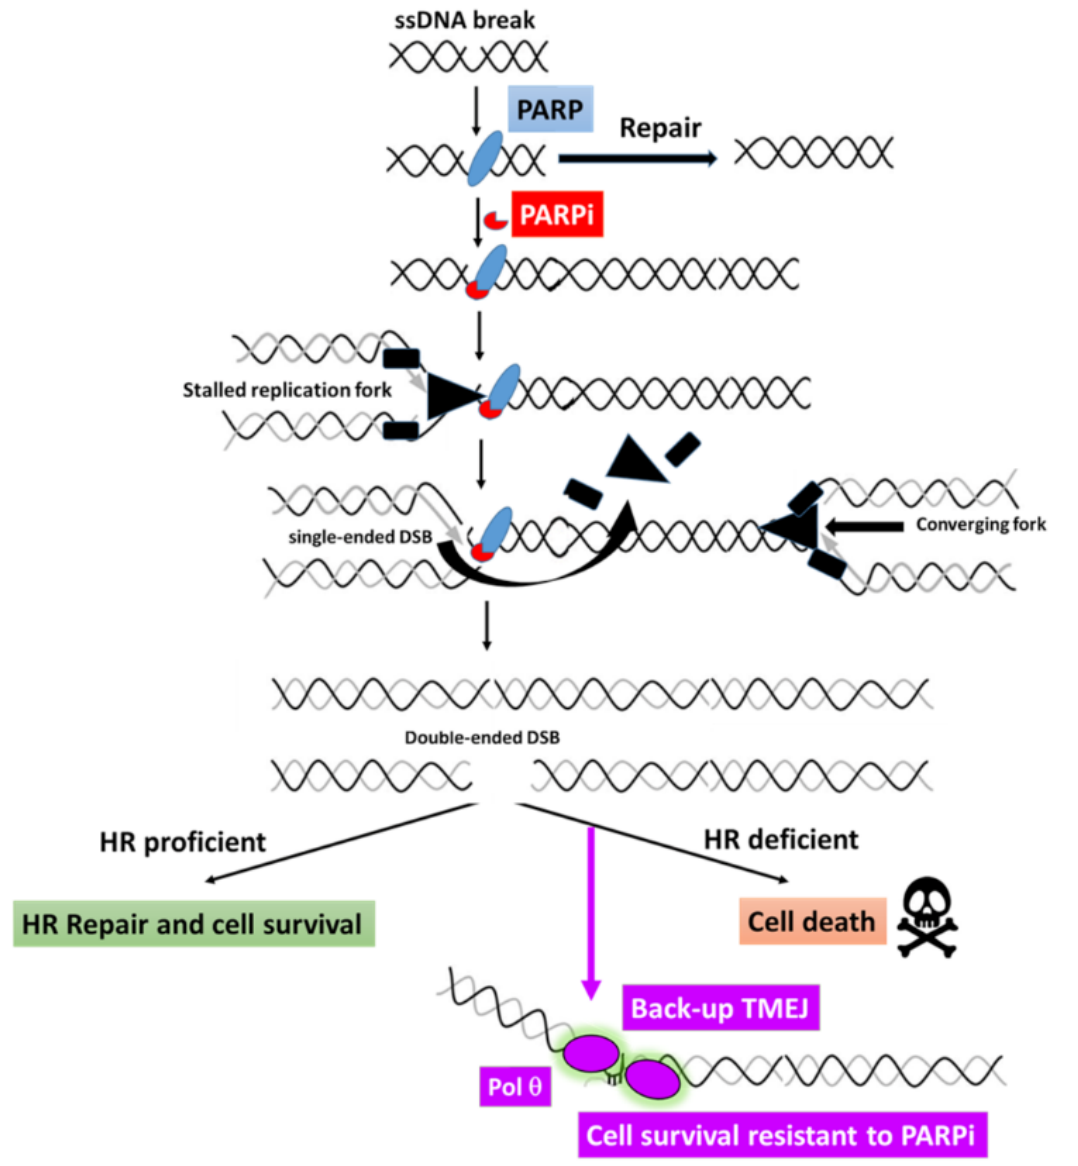
Figure 3. Rationale for targeting theta-mediated end joining (TMEJ) in PARPi-resistant breast cancers. The poly(ADP-ribose) polymerase (PARP) is responsible for the repair of single-stranded DNA (ssDNA) breaks. The PARP inhibitors inhibit the catalytic activity of PARP and can trap PARP proteins on the DNA. These bulky complexes impede the progression of DNA replication forks, which stall, leads to unloading of the replicative helicase and DNA polymerases, and creates a single-ended DSB. When a converging fork is coming, a double-ended DSB is generated. This DSB can be resolved by a functional HR machinery, leading to cell survival. When HR is defective, the damage persists, leading to cell death. One mechanism explaining primary or secondary resistance to PARPi relies on the activation of the alternative Pol θ -mediated End-Joining (TMEJ) DSB repair pathway which can rescue HR defect. Abbreviations: HR = homologous recombination; ssDNA = single-stranded